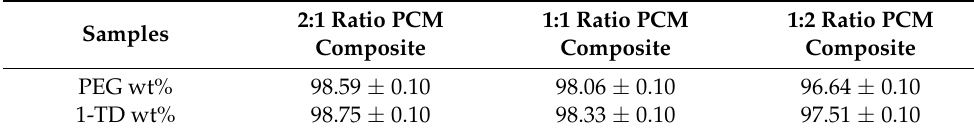
Table 2. Weight percentages of PCM with different GNP mass ratios.